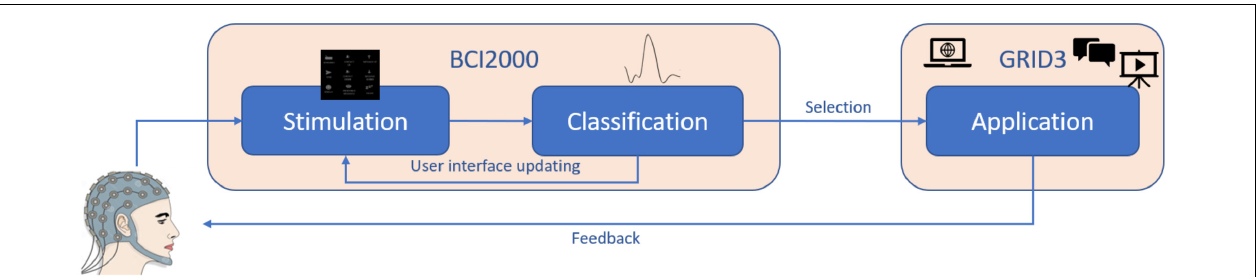
FIGURE 1 | Illustration of the system design and the relationship between the software